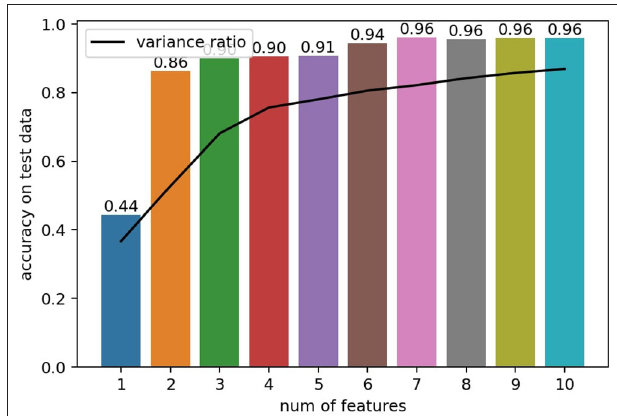
FIGURE 7 | Number of (incremental principal component analysis, IPCA) features vs. Classification accuracy of a k-NN classifier, with k = 10 using half of the dataset as a test set. The black line follows the ratio of variance explained by the principal